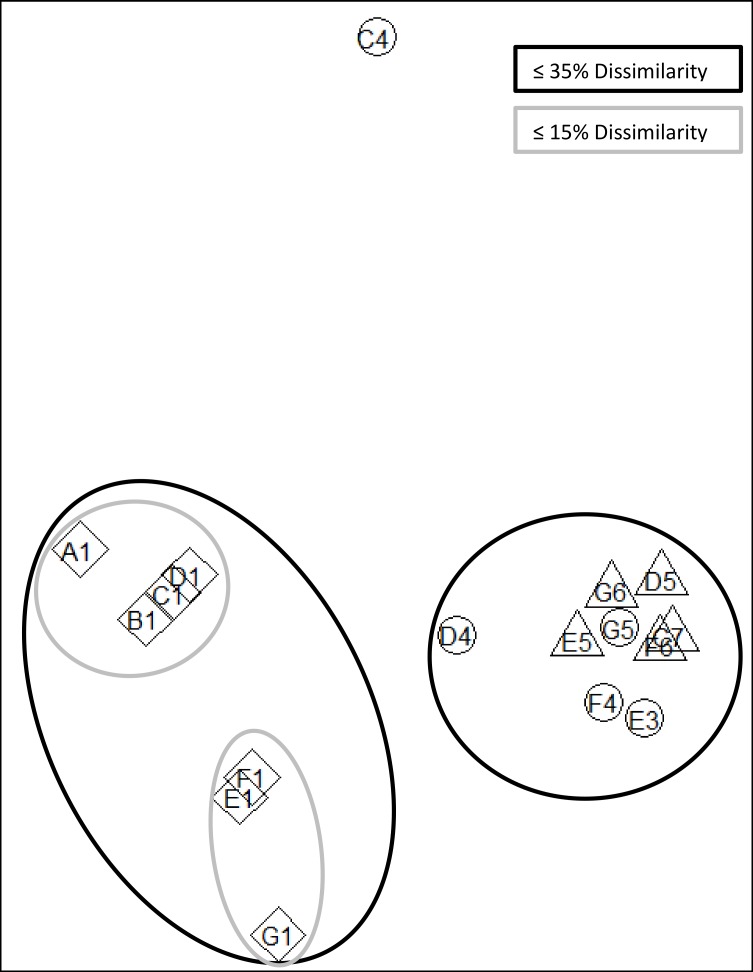
Non-metric multidimensional scaling (nMDS) ordination of fourth root transformed species data at each site sampled during cruise DY017 to the N.W. European shelf.The stress is 0.036 indicating that ordination is representable for real patterns rather than randomness in the data. (Triangle = oceanic stations, circle = shelf break stations, diamond = shelf stations).